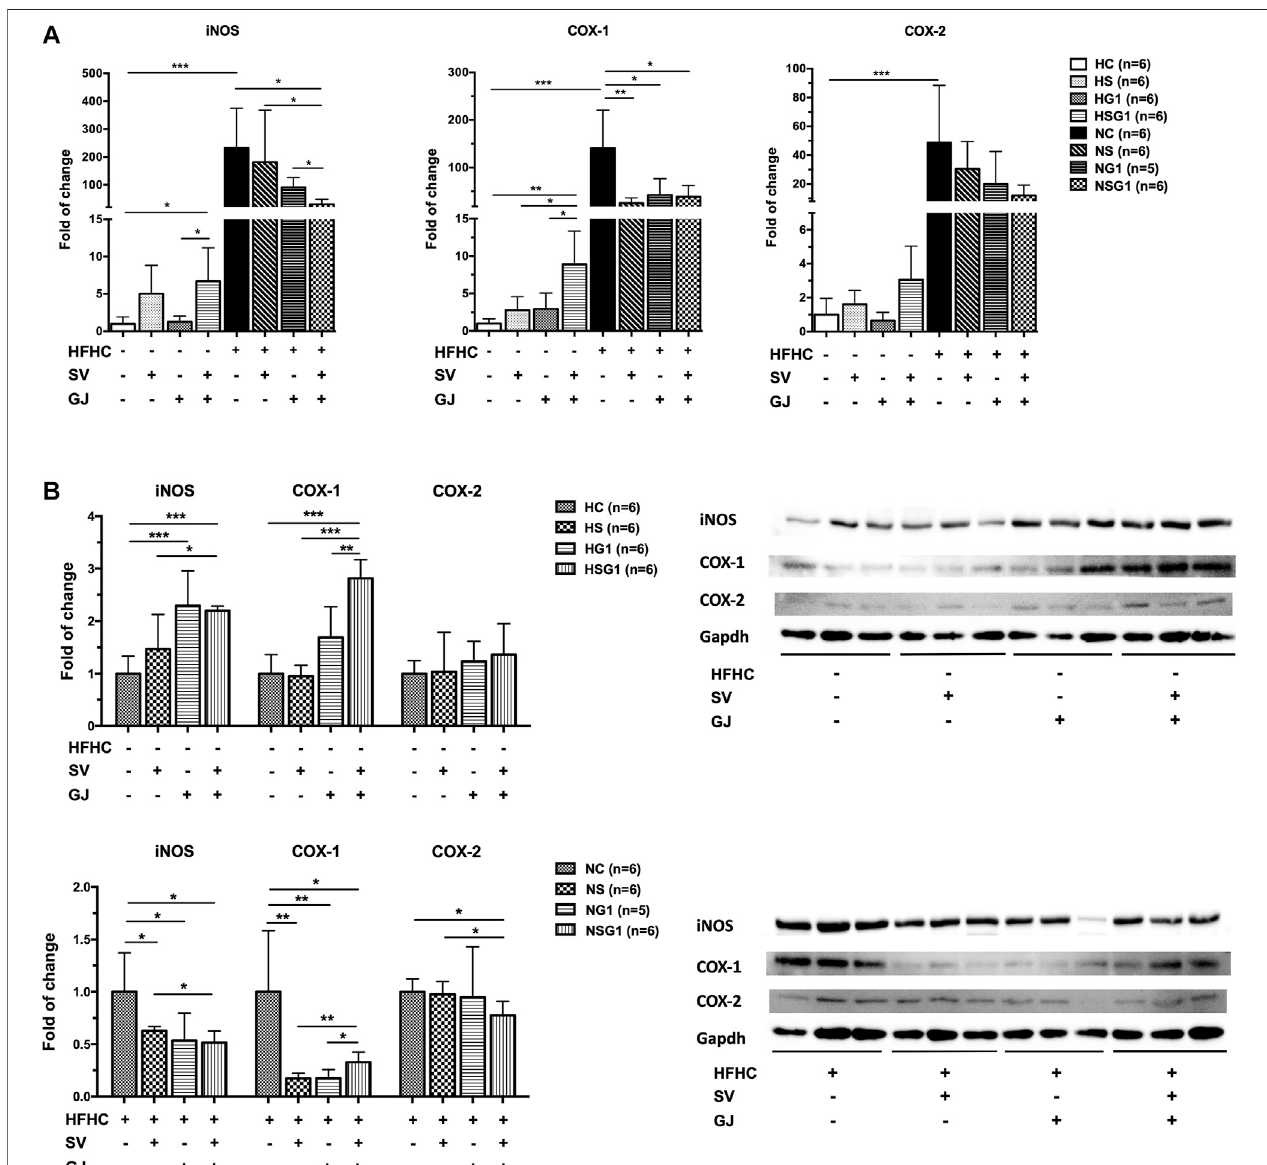
FIGURE 8 | Hepatic mRNA (A) and protein (B) levels of iNOS, COX-1, and COX-2 in healthy and NASH rats which received vehicle (HC and NC), SV (HS and NS), GJ(HG1andNG1),andtheircombination(HSG1andNSG1)withrepresentativebands.HandNdenotedhealthyandNASH,respectively.C,S,andGindicatedthatthe rats received vehicle, SV, and GJ, respectively. * p < 0.05, ** p < 0.01, and *** p <